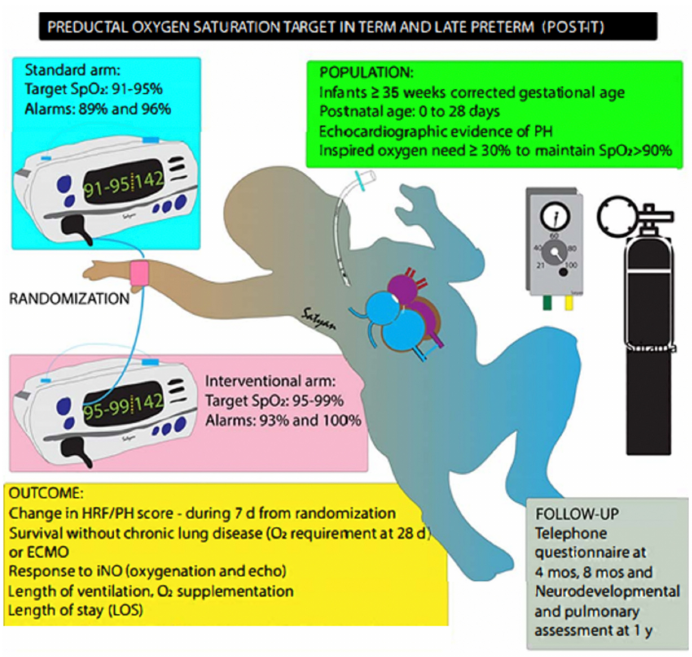
Figure 6. Overview of study design and objectives. Copyright Satyan Lakshminrusimha .